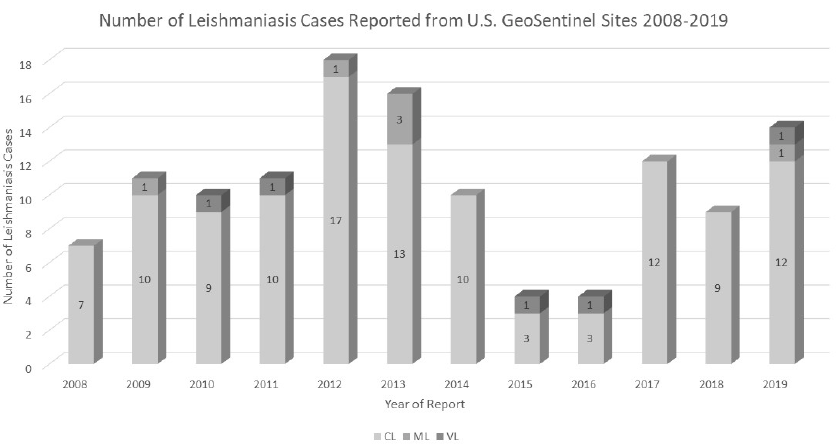
Figure 1. Number of Returned Travelers Reported from a U.S. GeoSentinel Surveillance Network Site with a Diagnosis of Leishmaniasis from 2008–2019. CL = cutaneous leishmaniasis, ML= mucosal leishmaniasis, and VL = visceral leishmaniasis. (Data kindly provided courtesy of Dr. Michael Libman and the GeoSentinel Surveillance Network) .